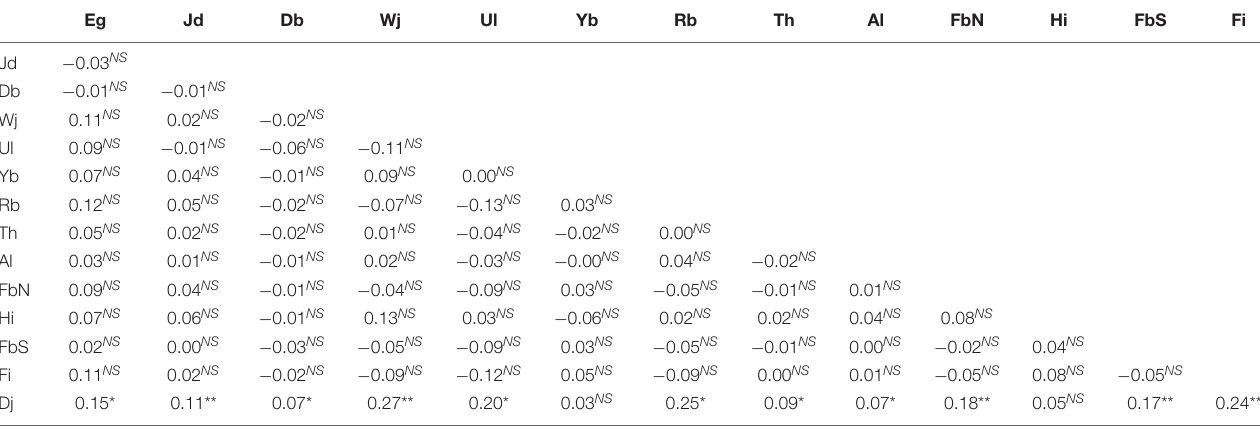
TABLE 3 | Pairwise φ ST values between populations of Tridacna maxima in the RSGA, based on mitochondrial cytochrome c oxidase I sequences. Eg Jd Db Wj Ul Yb FbN